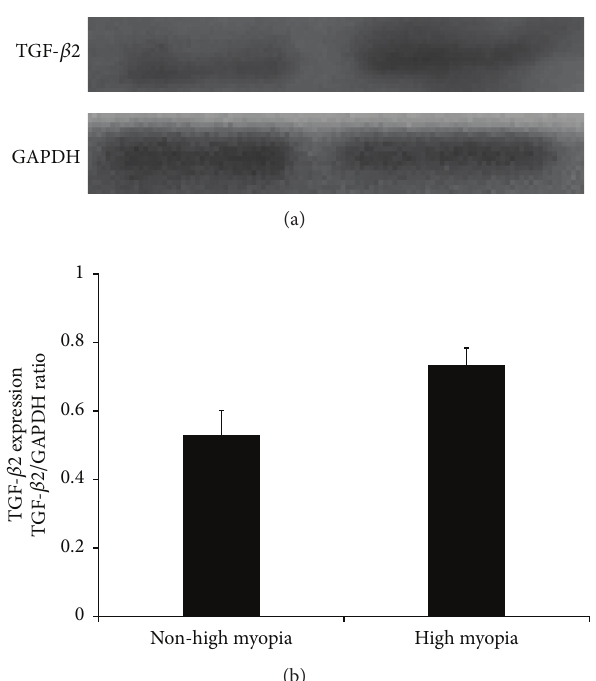
Figure 4: TGF- 𝛽 2 expression in the aqueous humor of capsular contraction syndrome patients. Western blot of CCS cases showed higher TGF- 𝛽 2 levels in the CCS with high myopia compared with those without high myopia, consistent with our previous ELISA results. TGF- 𝛽 2 = transforming growth factor- 𝛽 2; CCS = capsular contraction